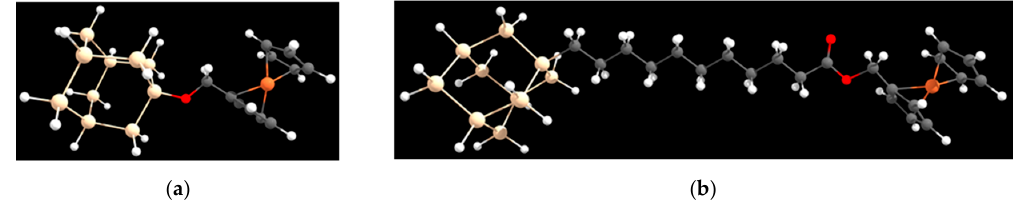
Figure 1. Molecular architectures grafted on the Si(111) slab: ( a ) Si 10 H 15 –O–CH 2 –FC cluster, in the text